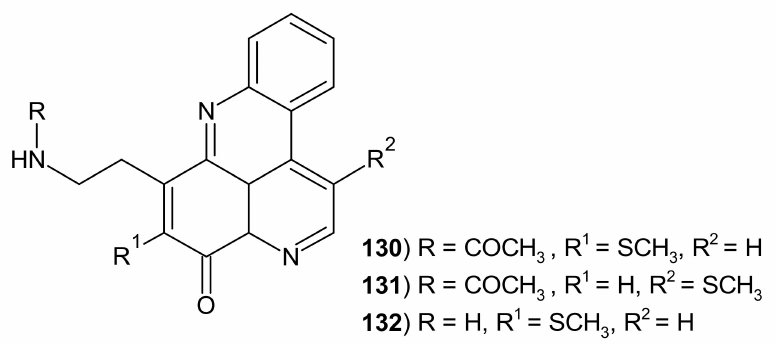
Figure 34. Diplamines 130–132.